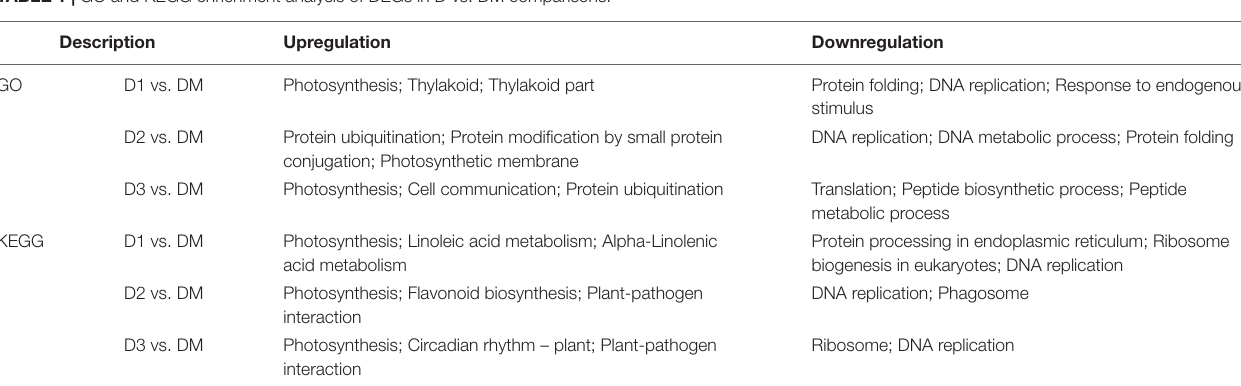
FIGURE 1 | DEGs and significant KEGG pathways for DEGs in D vs. DM, L vs. DM, and L vs. D. (A) The numbers of DEGs in D vs. DM, L vs. DM, and L vs. D; the treatment diagram is shown at the bottom of the bar chart and the specific materials and treatment are shown in Supplementary Figure 1b ; (B) significant KEGG pathways for DEGs in D vs. DM; (C) significant KEGG pathways for DEGs in L vs. DM; (D) significant KEGG pathways for DEGs in L vs. D. The “gene_ratio” means the ratio of the number of DEGs annotated in the KEGG pathway to the total number of DEGs that can be annotated in the KEGG database. TABLE 1 | GO and KEGG enrichment analysis of DEGs in D vs. DM